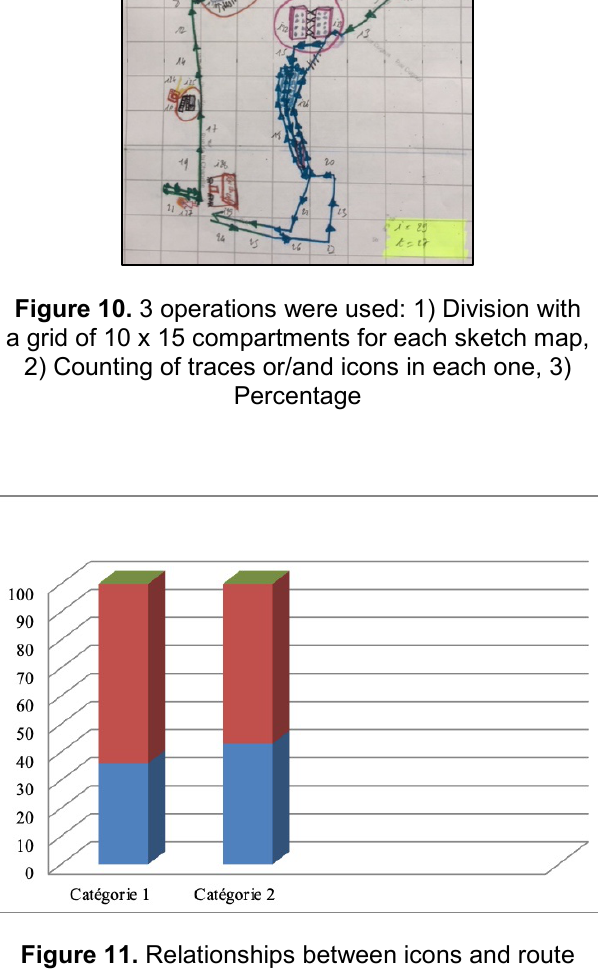
Figure 11. Relationships between icons and route trace drawings, for group 1 &